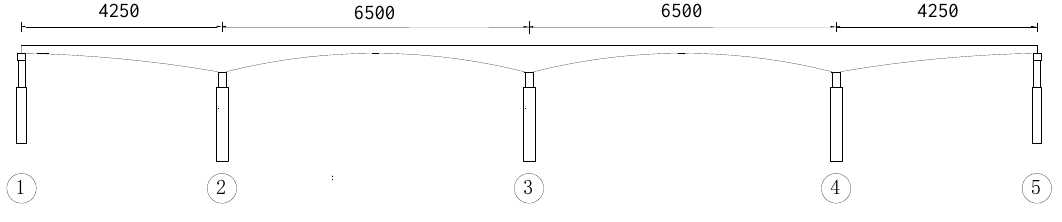
Figure 3. Bridge Elevation View (unit: cm).